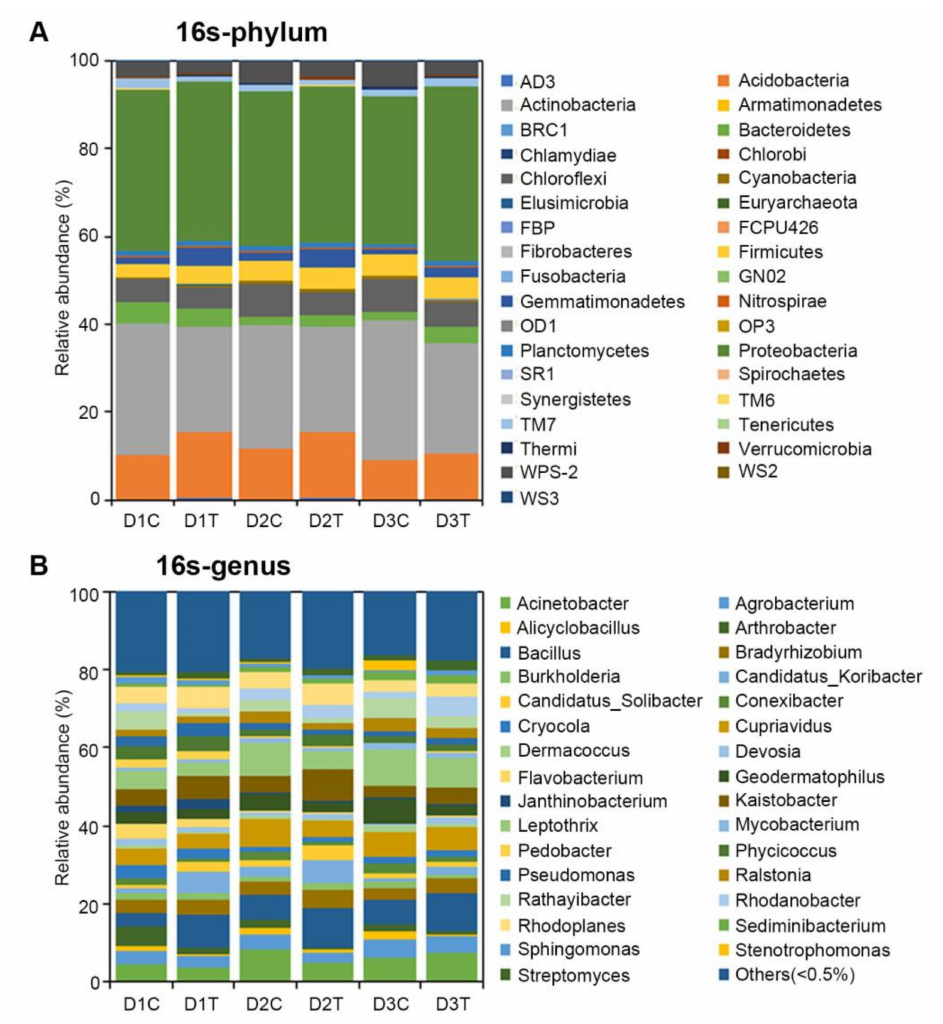
Figure 3. Relative abundances (percentage of sequences) of bacteria at phylum ( A ) and genus ( B ) levels in each